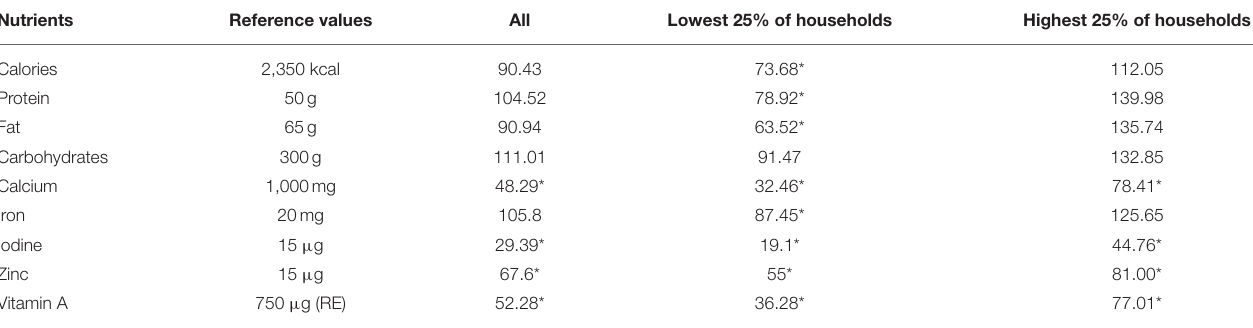
TABLE 7 | Adequacy ratio of nutrient consumption for all households, the lowest 25% of households by income and the highest 25% of households by income. Nutrients Reference values